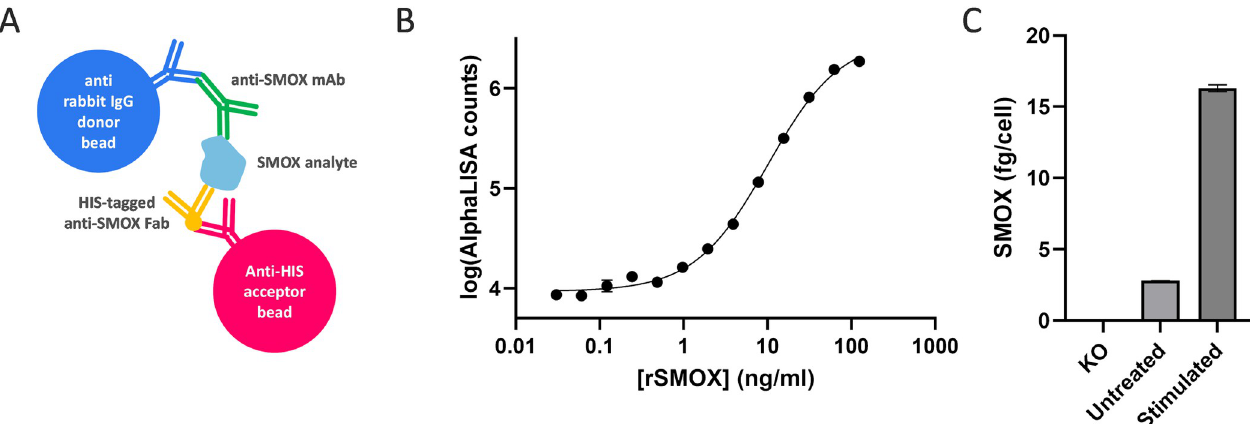
Fig 5. SMABS in hSMOX detection AlphaLISA assay. (A) schematic representation of the assay principle. (B) Example rhSMOX calibration curve with each [rhSMOX] in duplicate using the final assay format as explained in the main text (EC50 = 10.1 ng/ml; 95% confidence interval 9.0–11.3 ng/ml; R 2 = 0.997). Note that the symbol size is larger than the standard deviation of duplicate measurements for the majority of calibration points. (C) Use of the assay to quantify native hSMOX in A549 cells in which the hSMOX gene was knocked-out (KO), untreated A549 cells, and BENSpm stimulated A549 cells expressed in fg/cell. All data points represent the averages ± std of duplicate